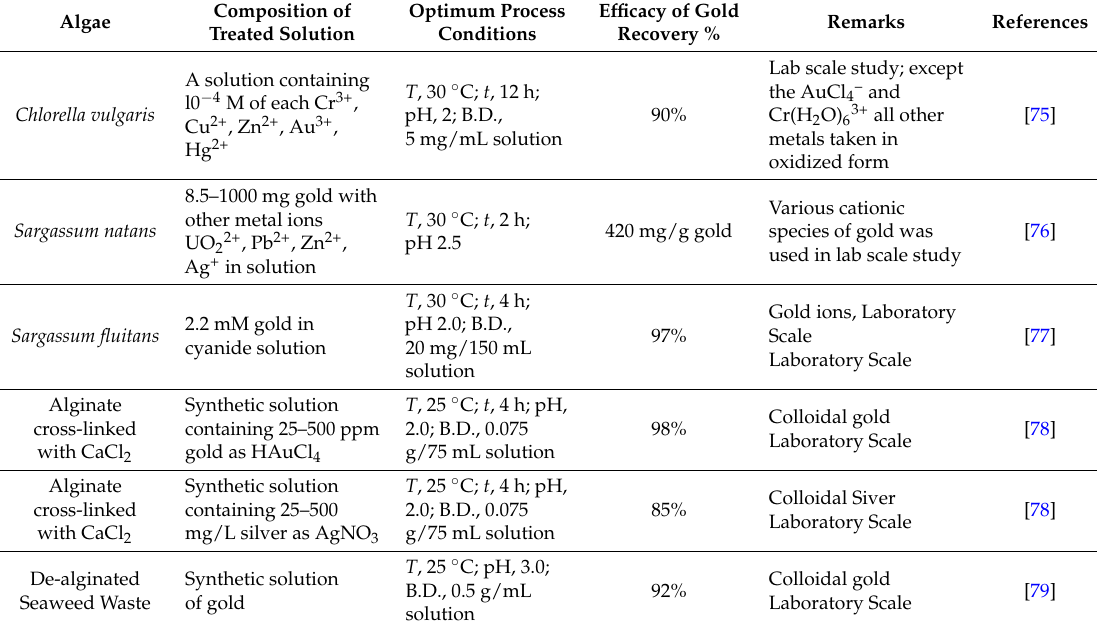
Table 2. A summary for the biosorption studies of gold by dead biomass of algae ( T = temperature; t = contact time; B.D. = biosorbent dosage).